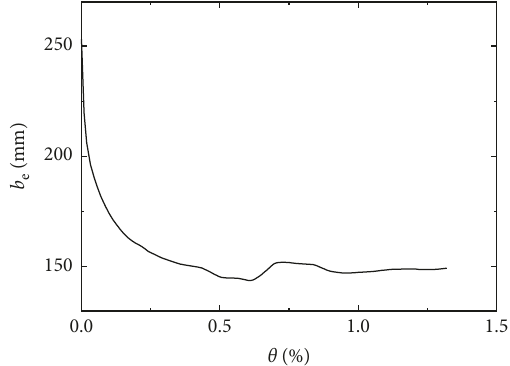
Figure 18: Effective width of specimen CW4X-D(FEA).